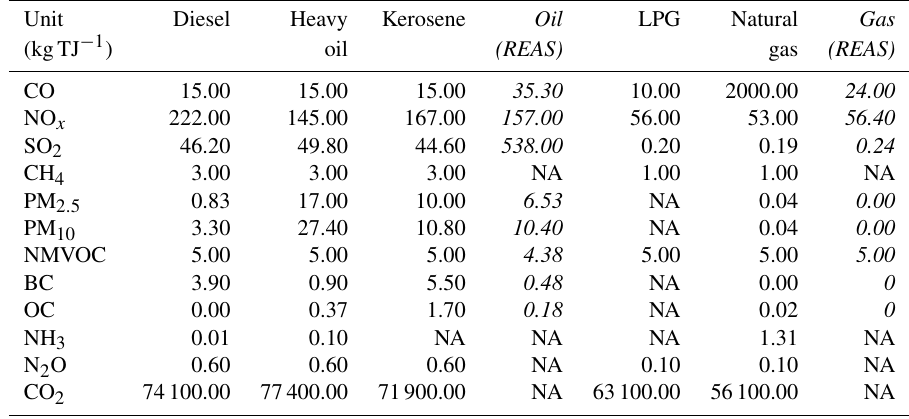
Table 16. Comparison of emission factors used for the industry sector in this study and in REAS v2.1. Italic numbers refer to emission factors used in REAS